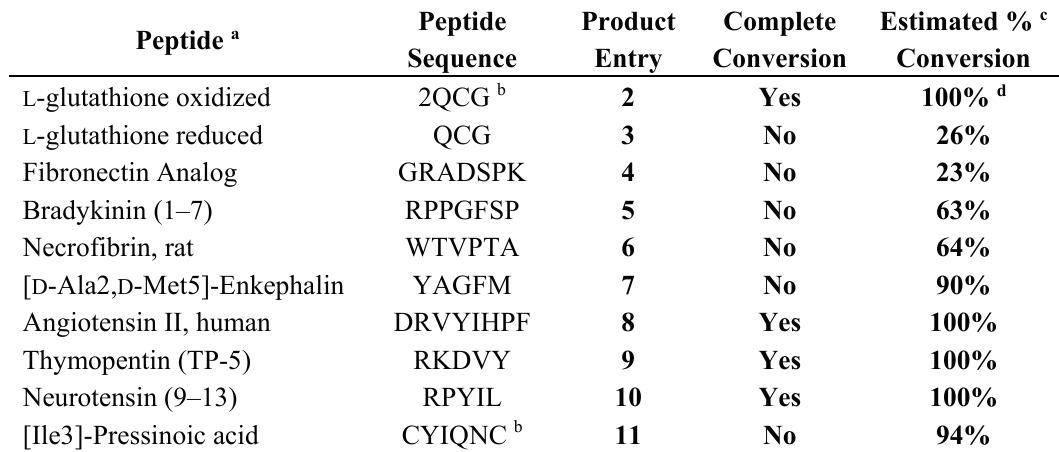
Table 1. Peptides subjected to the thionyl chloride esterification with methanol and analyzed via